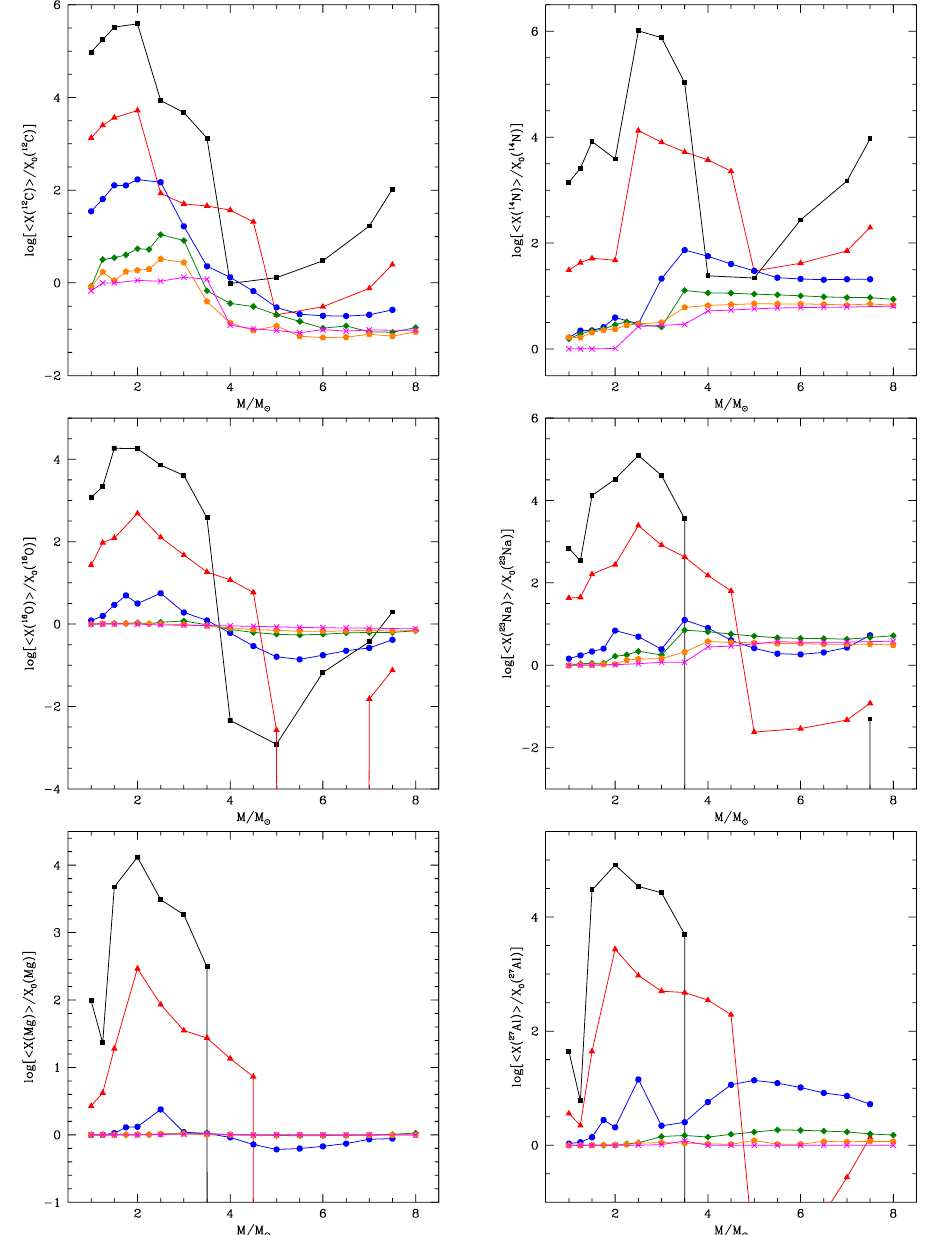
Figure 9. Ratio of the average abundance of different chemical species with respect to the initial mass fraction as a function of the initial mass of the star. The different colours and symbols have the same meaning as in Figures 6 and